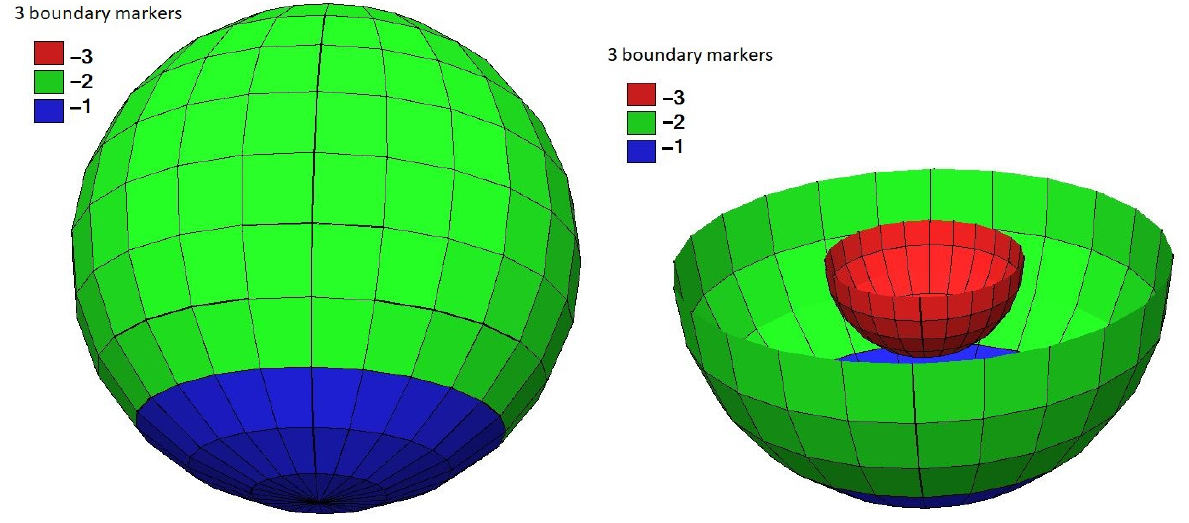
Figure 2. Wireframe structure of the surface of a 3D globe mesh. Bouton membrane— green , neurotransmitter release area— blue , supply zone boundary— red